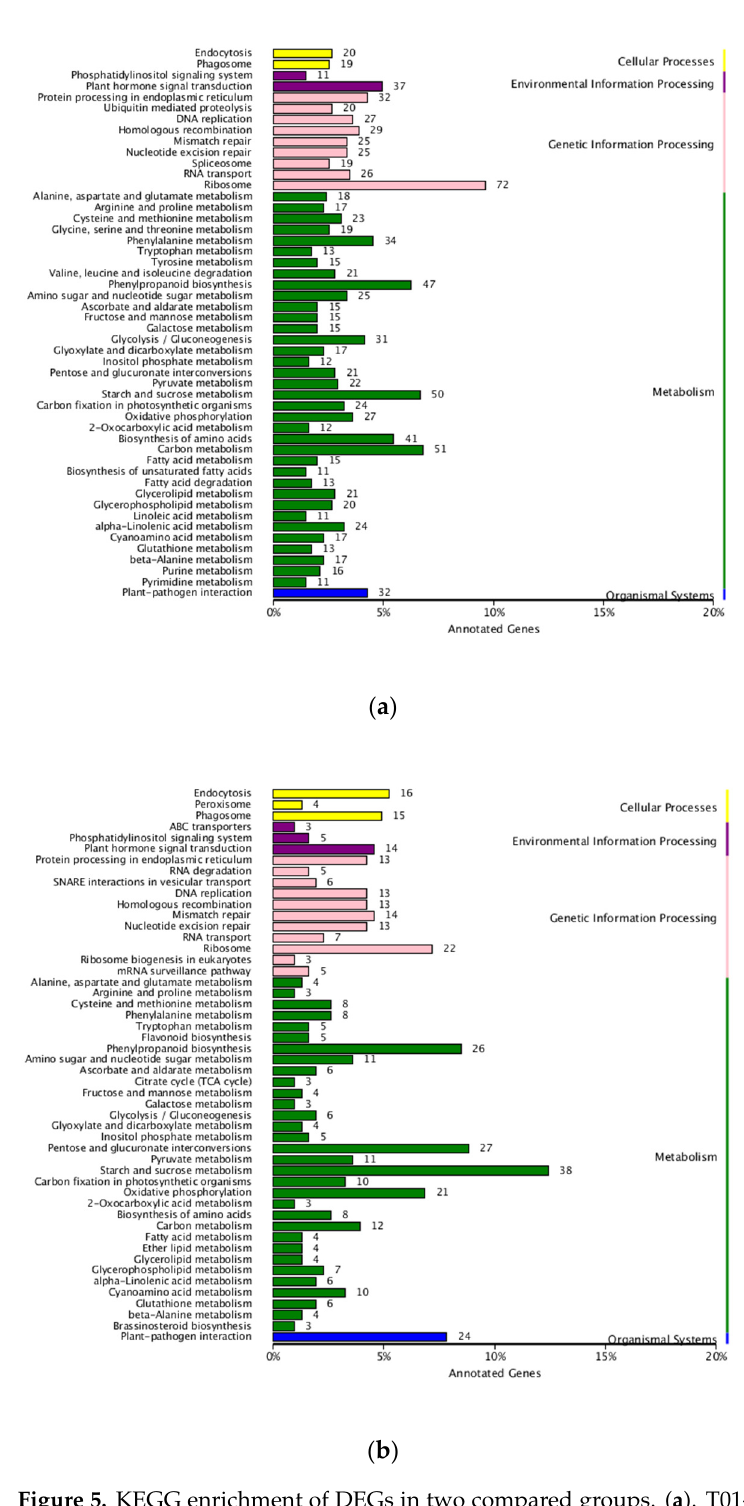
Figure 5. KEGG enrichment of DEGs in two compared groups. ( a ). T01-vs.-T02 compared group. ( b ). T04-vs.-T03 compared group.